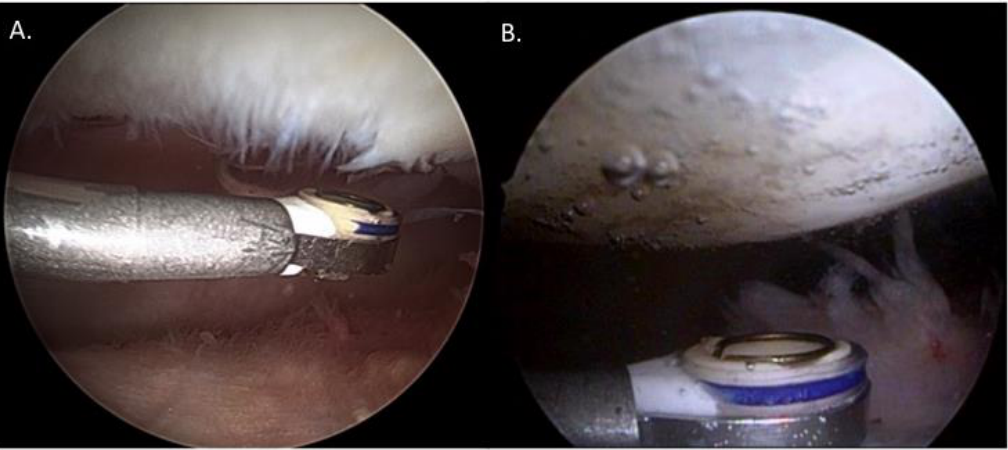
Figure 1. ( A ) Intraoperative finding of the articular cartilage grade II lesion on the medial patella and ( B ) directly after radiofrequency chondroplasty, respectively.